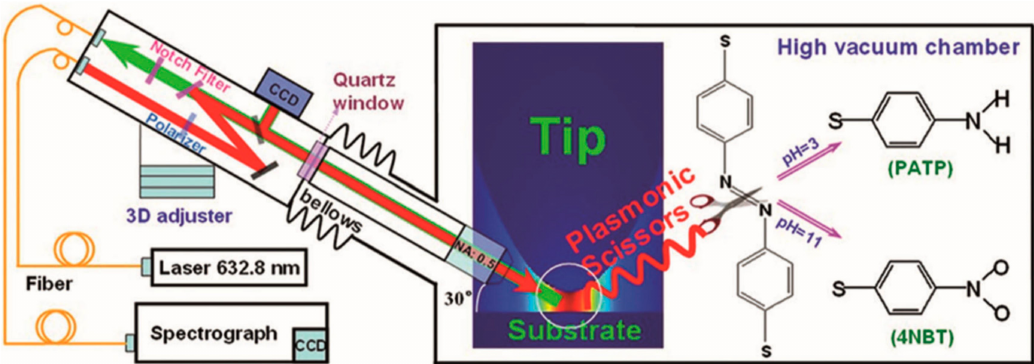
Figure 8. Diagram of plasmonic scissors and the corresponding dynamic process